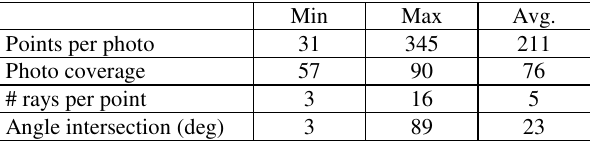
Table 11. St. Jean: block strength